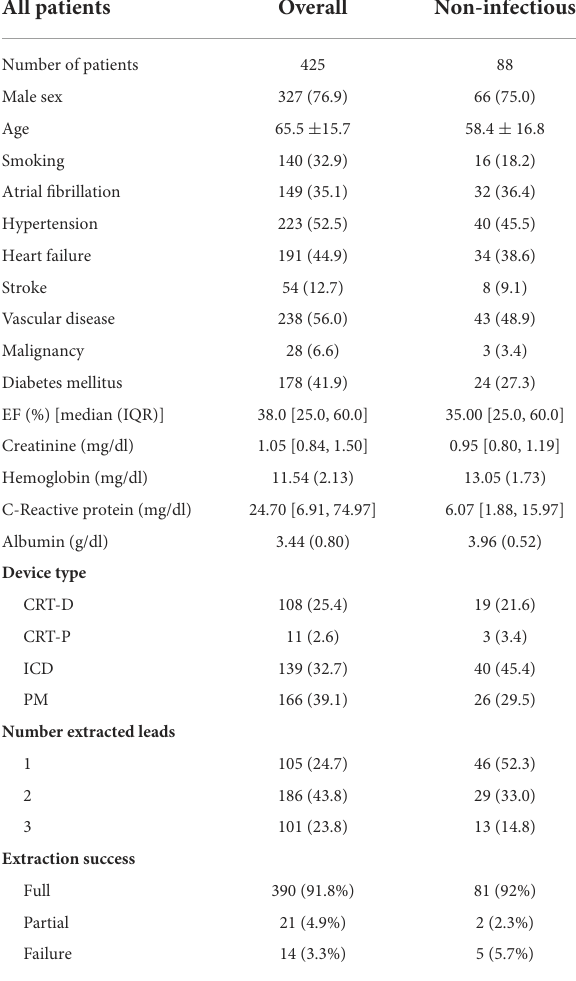
TABLE 1 Patient characteristics of the entire